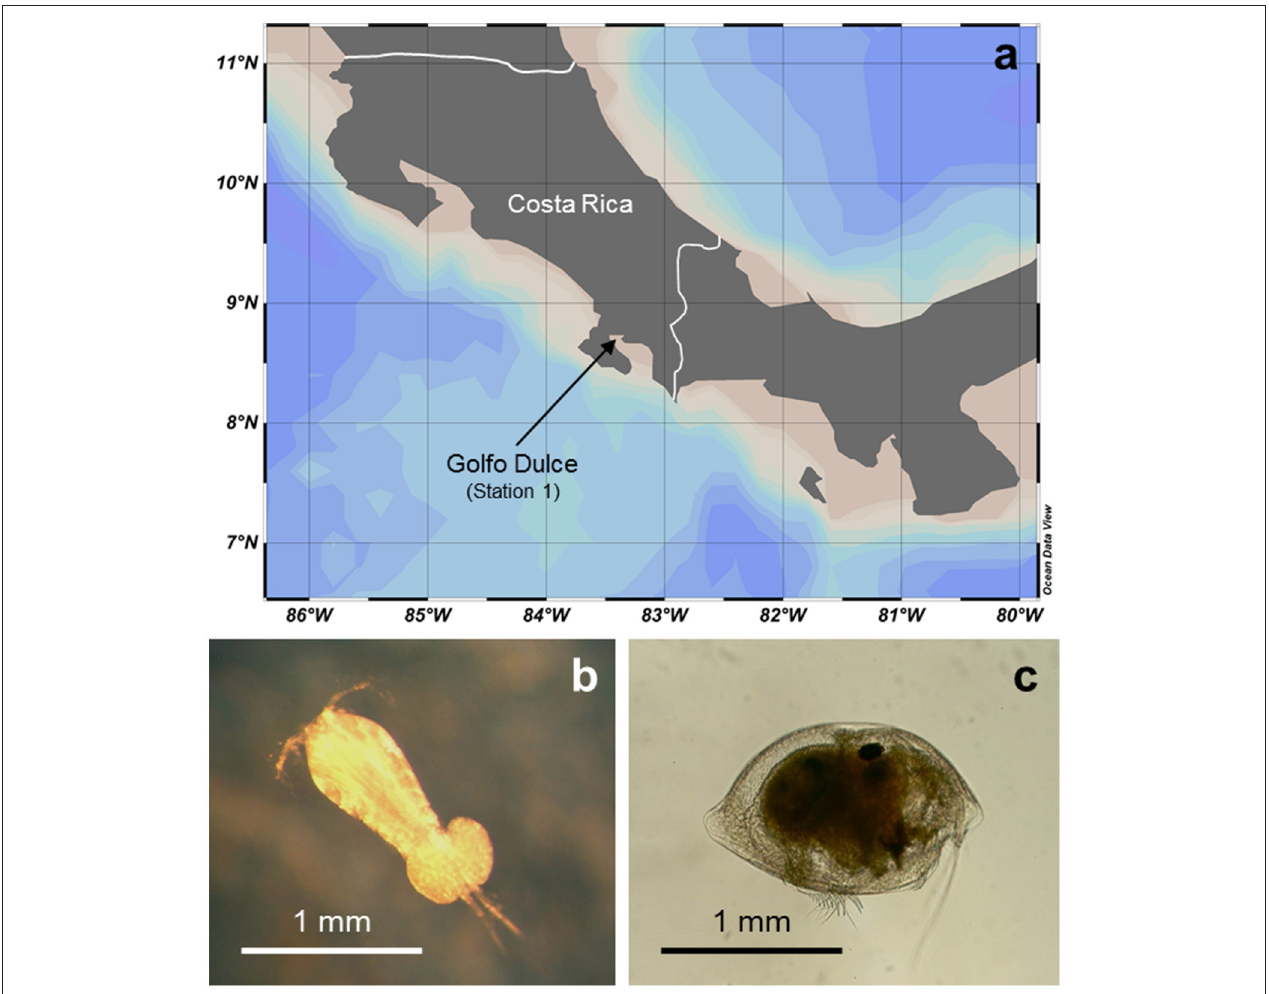
FIGURE 1 | Study site and representative zooplankton. (a) Geographical location of Golfo Dulce (GD) at the Pacific coast of Costa Rica; the tip of the arrow points to the targeted sampling station. (b) Oncaea sp., the most abundant copepod and (c) Cypridina sp., the most abundant ostracod in GD at the time of the current study. See Table S2 for detailed list of identified